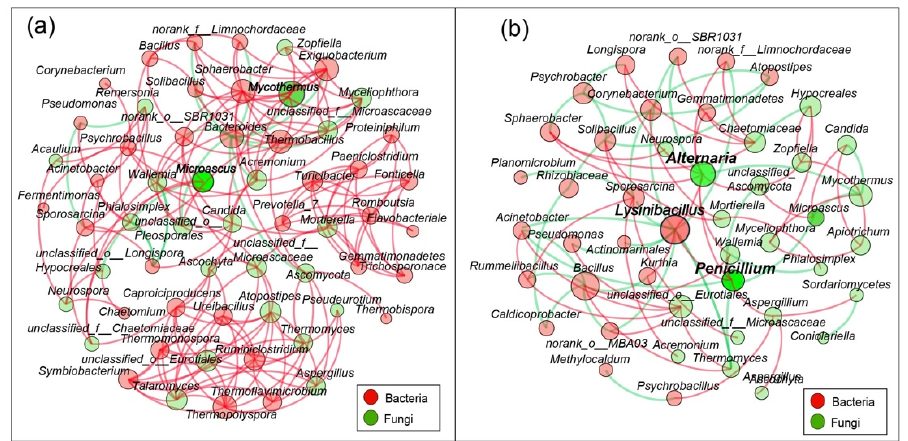
Figure 5. Network analysis showing the cooccurrence based on the interaction relationship among dominant genera. The control group ( a ); LF-N1 and DH-1 inoculation groups ( b ). Red edges: positive correlation; green edges: negative correlation. The size of the nodes shows the average RA of the taxa.